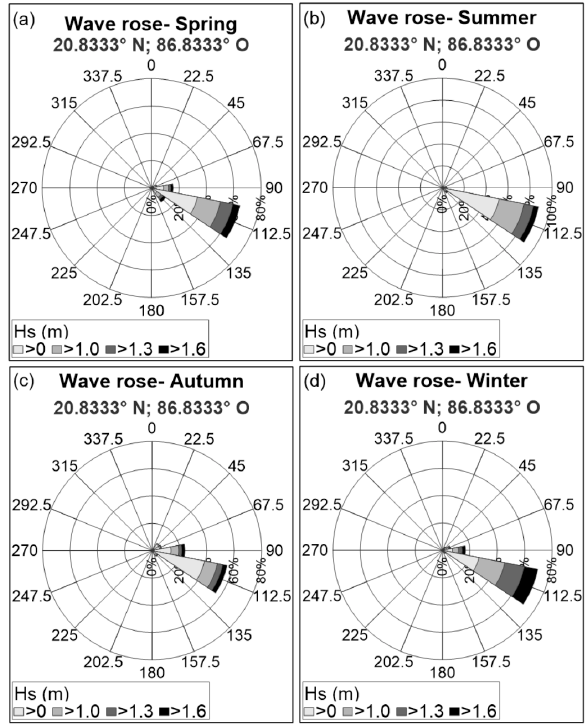
Figure 9. Seasonal wave roses: ( a ) Spring; ( b ) Summer; ( c ) Autumn; ( d ) Winter.